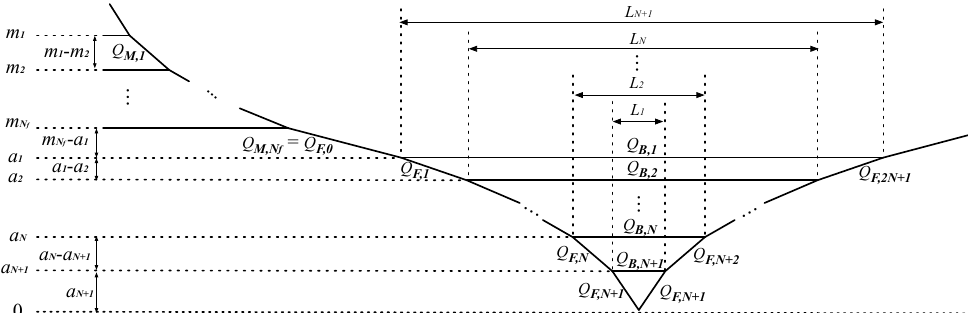
Figure 22 . Setup of